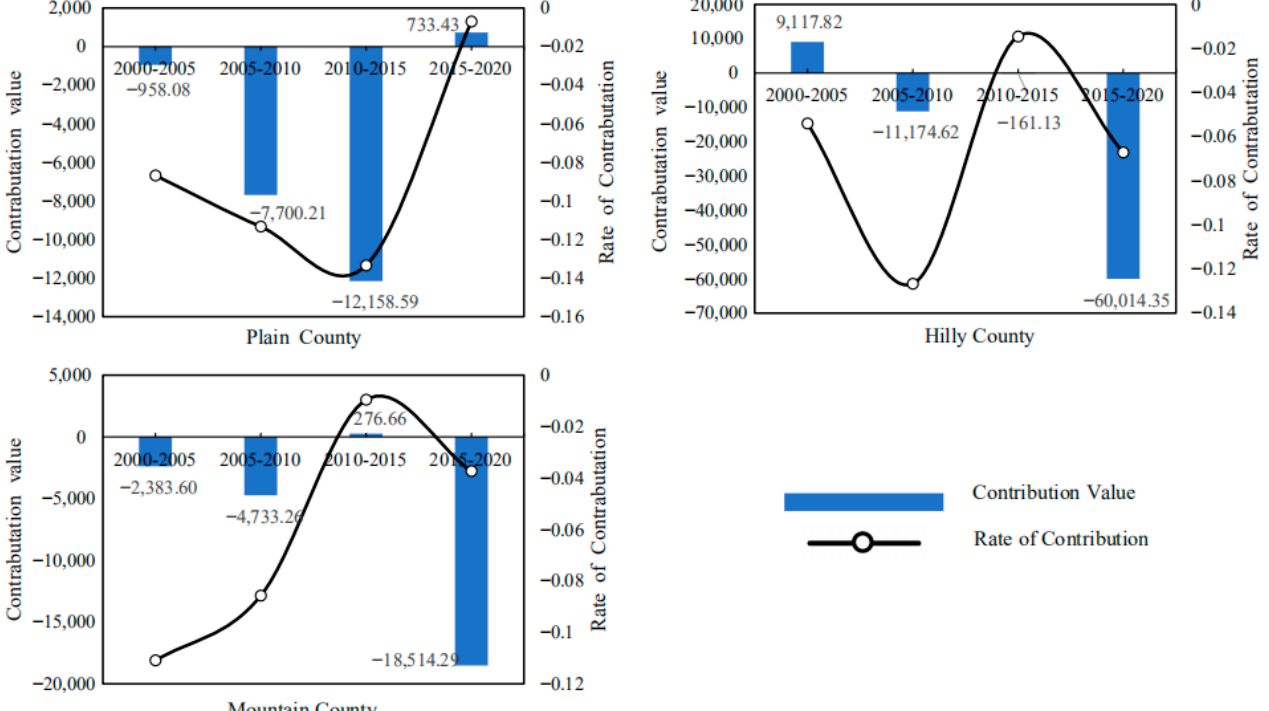
Figure 14. Topographic heterogeneity of emission reduction effect of agricultural labor scale (including Plain County, Hilly County, Mountain County).